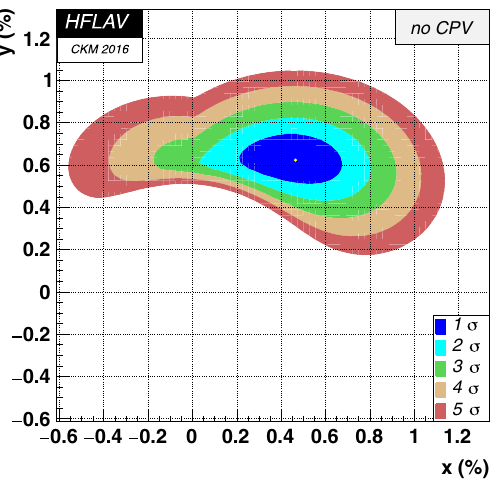
Fig. 194 Two-dimensional contours for mixing parameters ( x , y ) , for no CPV